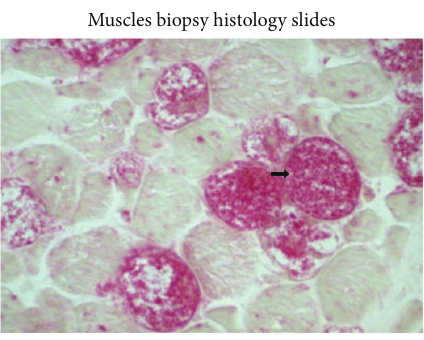
Figure 2: Vacuoles are stained with periodic acid Schiff